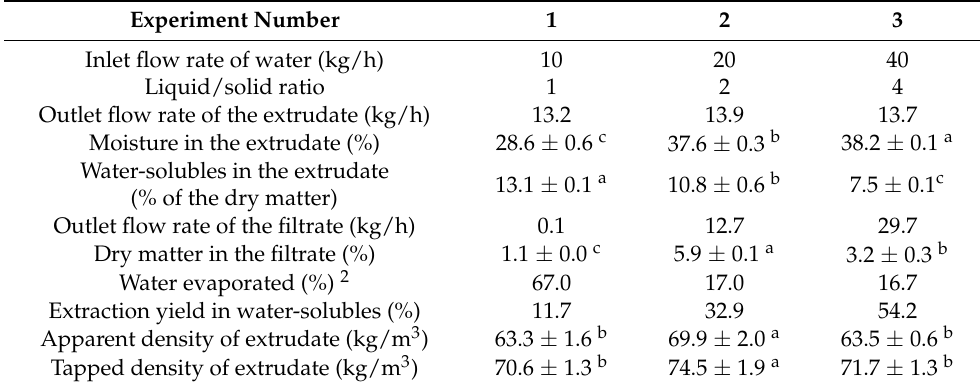
Table 7. Inlet flow rate of water, liquid/solid ratio, outlet flow rate of the filtrate, content of water- soluble components in the filtrate, extraction yield in water-soluble components, and apparent and tapped densities of the extrudate after drying for the three twin-screw extrusion-refining experiments applied to the amaranth bark particles (10 kg/h for their inlet flow rate) 1 . Experiment